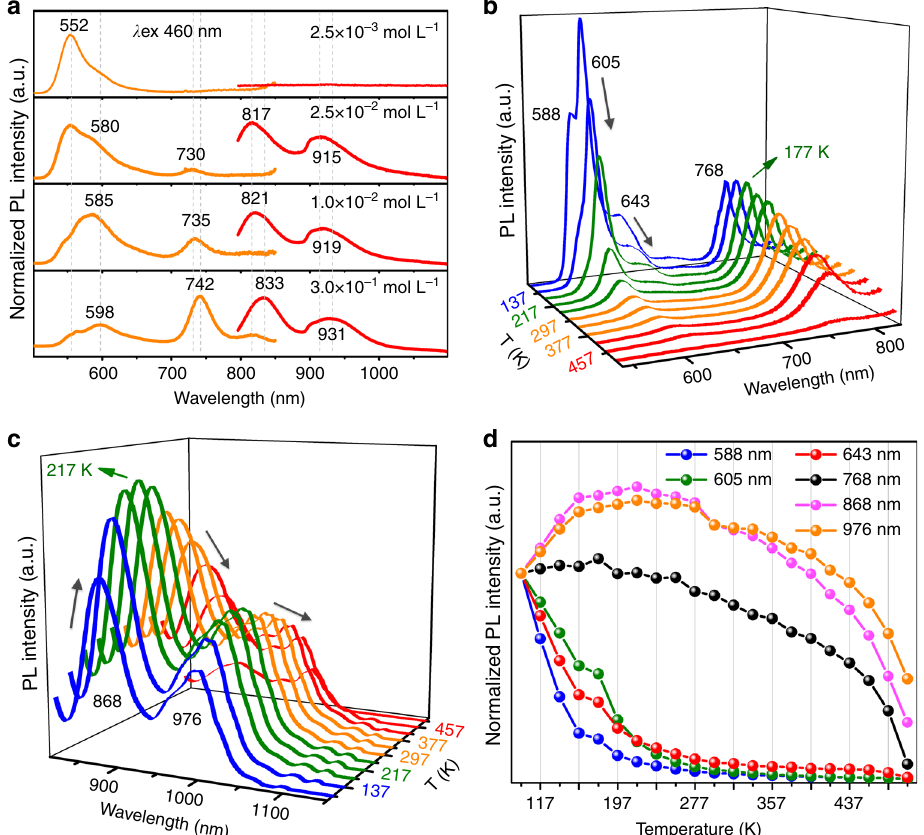
Fig. 3 Fluorescent properties of aggregation-state BDP1. a Normalized fl uorescence emission spectra of PMMA fi lms prepared at different doping concentrations of BDP1. b , c Temperature-dependent emission spectra of microcrystalline powder state BDP1 collected from 97 to 497 K, excited at 480 nm. d Plots of normalized emission intensity changes of the multi-emissions at varying